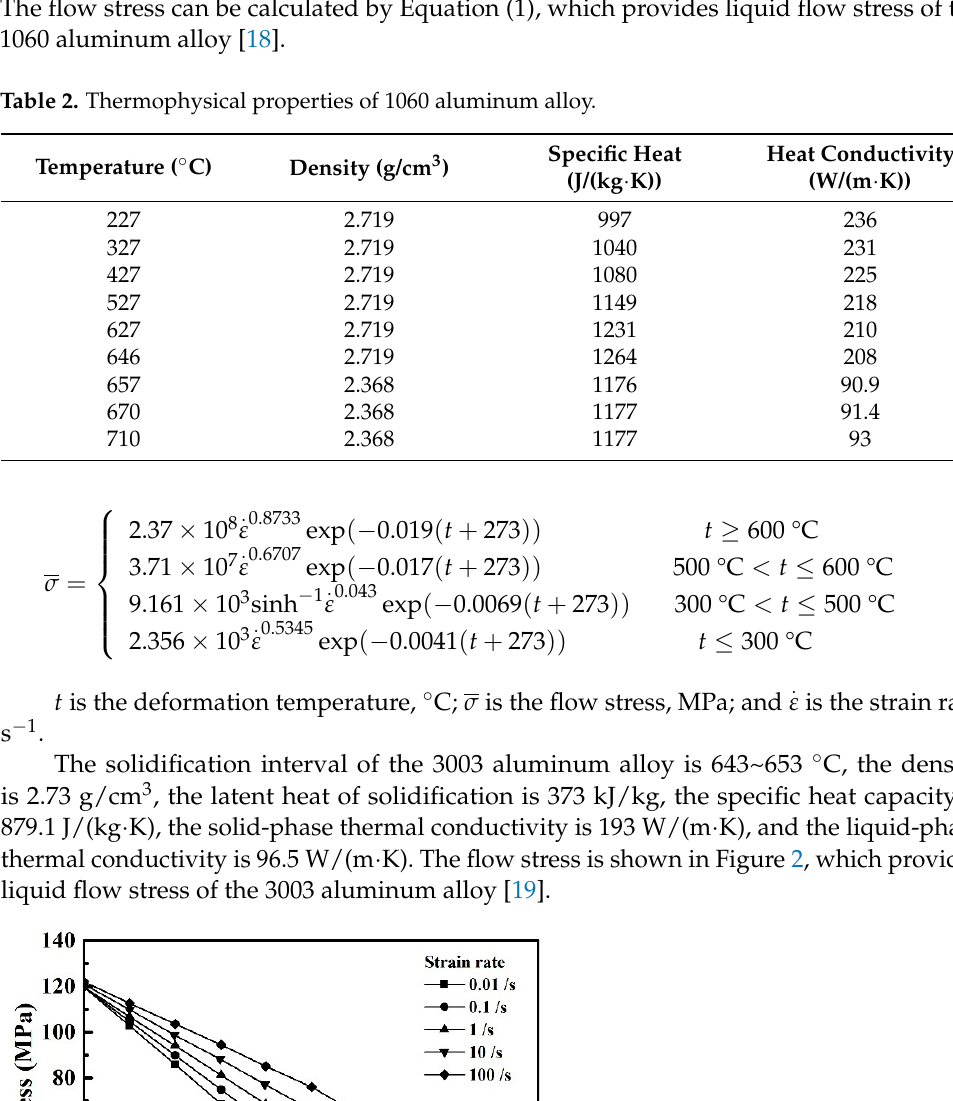
Table 3. Thermophysical properties of casting rolls.